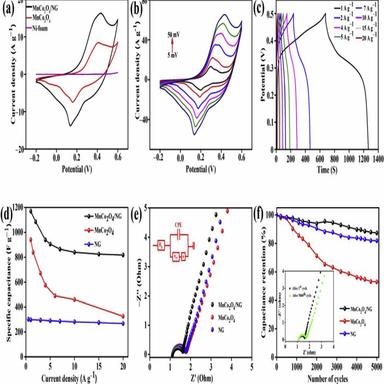
(a) CV curves of bare Niefoam, 2D MnCo2O4 NFs and the MnCo2O4/NG 2D/2D hybrid nanoarchitectures at a scan rate of 10 mV s1 , (b) CV curves of the MnCo2O4/NG 2D/2D hybrid nanoarchitectures at a different sweep rates (550 mV s1 ), (c) galvanostatic chargedischarge curves of the MnCo2O4/NG 2D/2D hybrid nanoarchitectures at different current densities from 1 to 20 A g1 , (d) specific capacitance vs. current density of the MnCo2O4/NG 2D/2D hybrid nanoarchitectures along with 2D MnCo2O4 NFs and 2D NG, (e) Nyquist